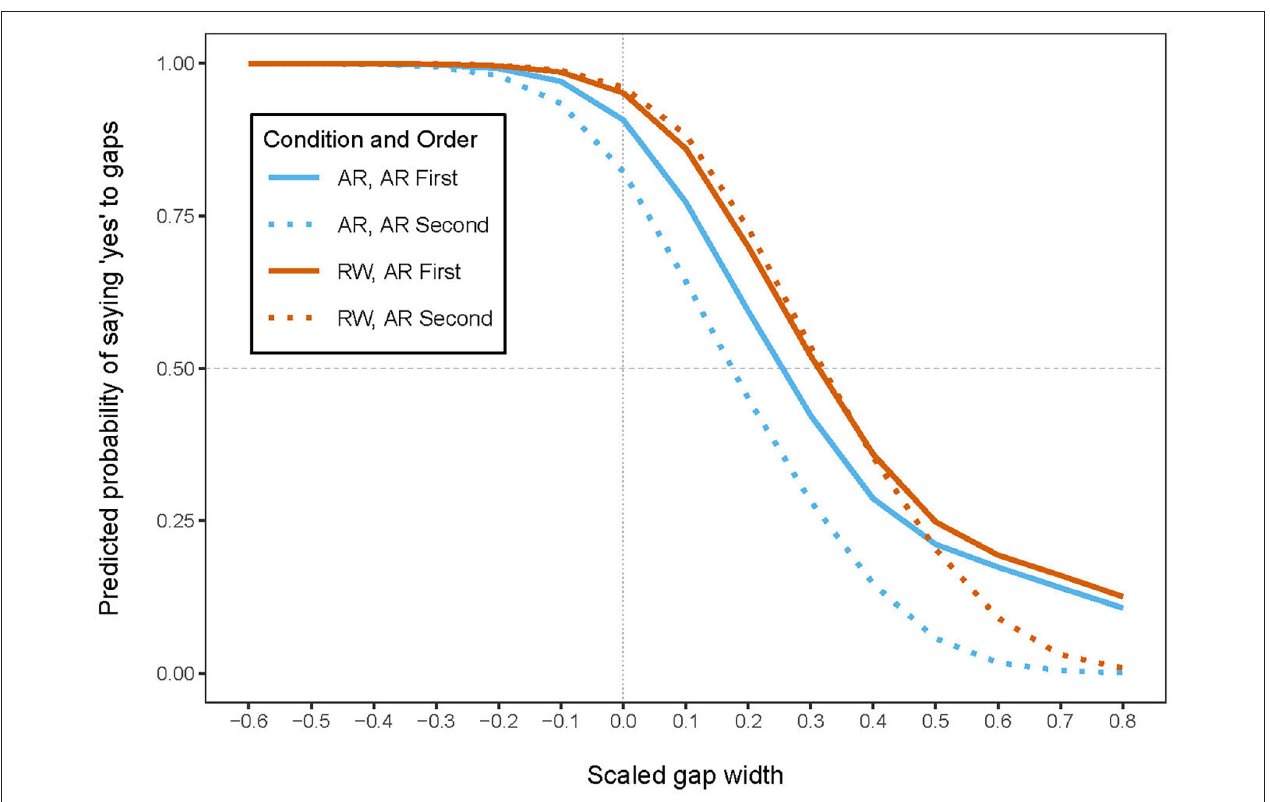
FIGURE 5 | Experiment 2 results. Predicted probability of saying “yes” to gap crossing as a function of scaled gap width for the AR condition (blue lines) and real-world condition (RW; orange lines) at two condition orders [AR experienced first (solid lines) and AR experienced second (dotted lines)]. The dotted line at x = 0.0 indicates when gap width = actual step length. The point of subjective equality (PSE) is the value of scaled gap width (on the x-axis) at which the curve intersects with y =